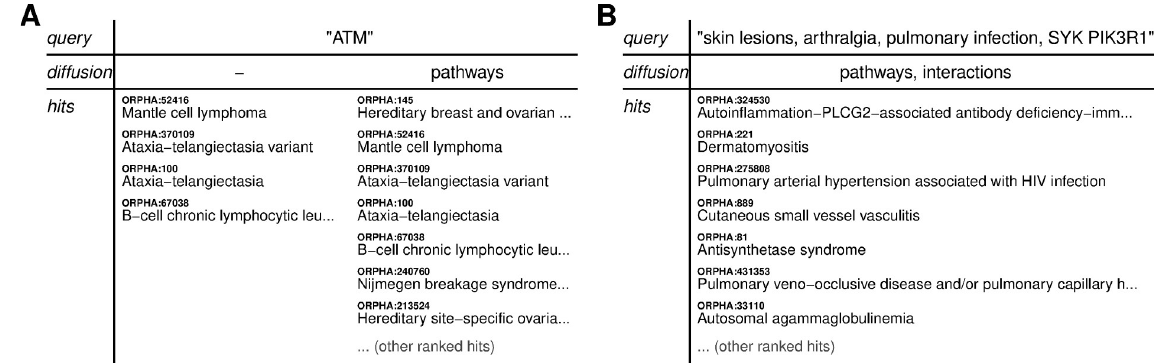
Fig 4. Examples of queries against a disease knowledge-base. (A) Results from a single-gene query with two diffusion settings. Hits are presented in ranked order. (B) Results from a multi-modal query with multiple phenotypes and genes.